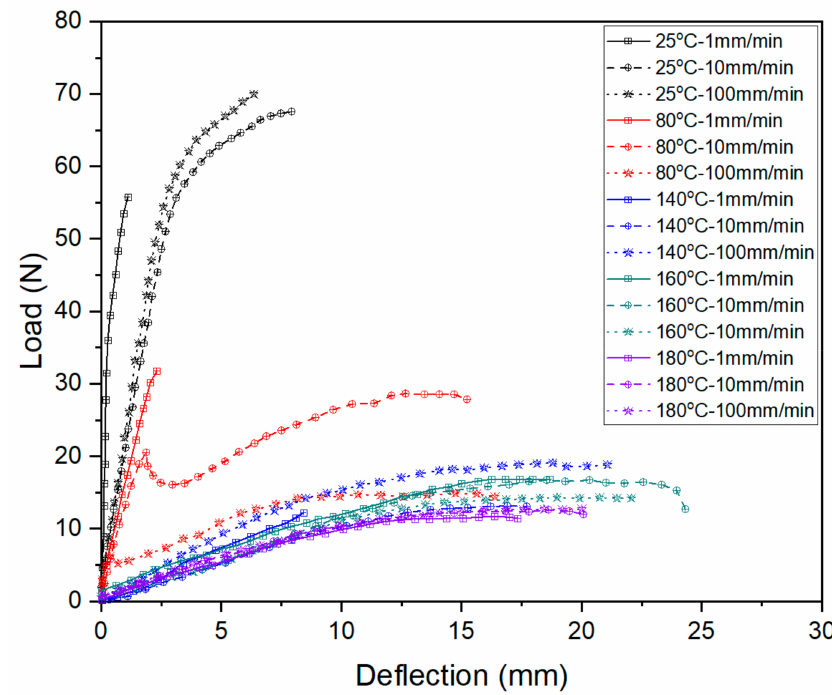
Figure 11. Bending load-deflection curves under different temperatures and